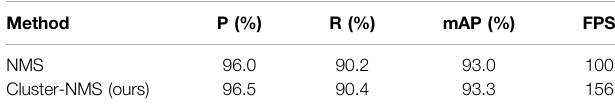
TABLE 3 | Details of experimental de fi nition.